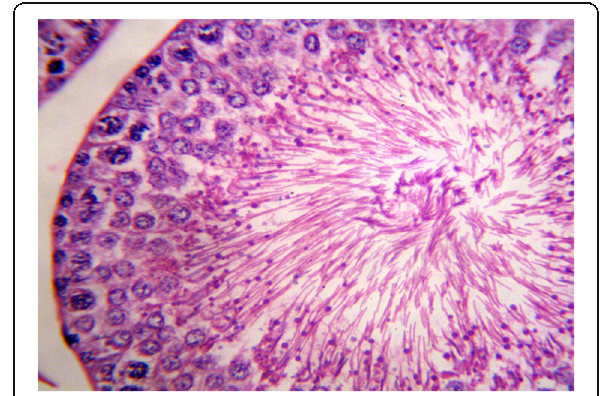
Fig. 2 Photomicrograph of rat's testis of control group rats , showing the normal histological structure (H & E X 400)